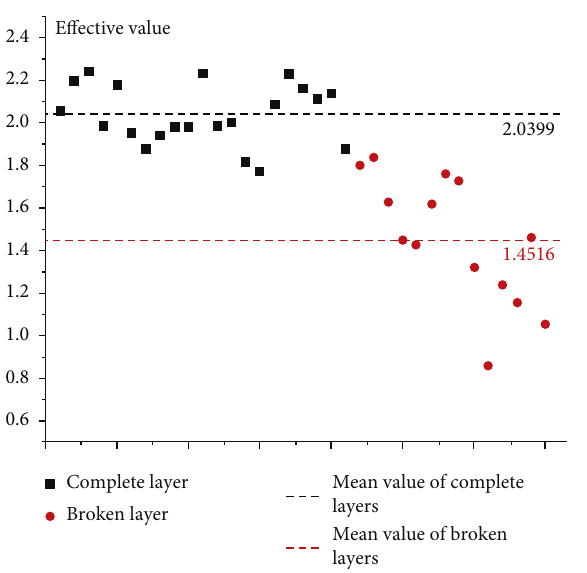
Figure 8: Pulse factor scatter